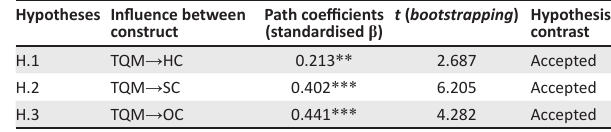
TABLE 3: Hypothesis contrast.